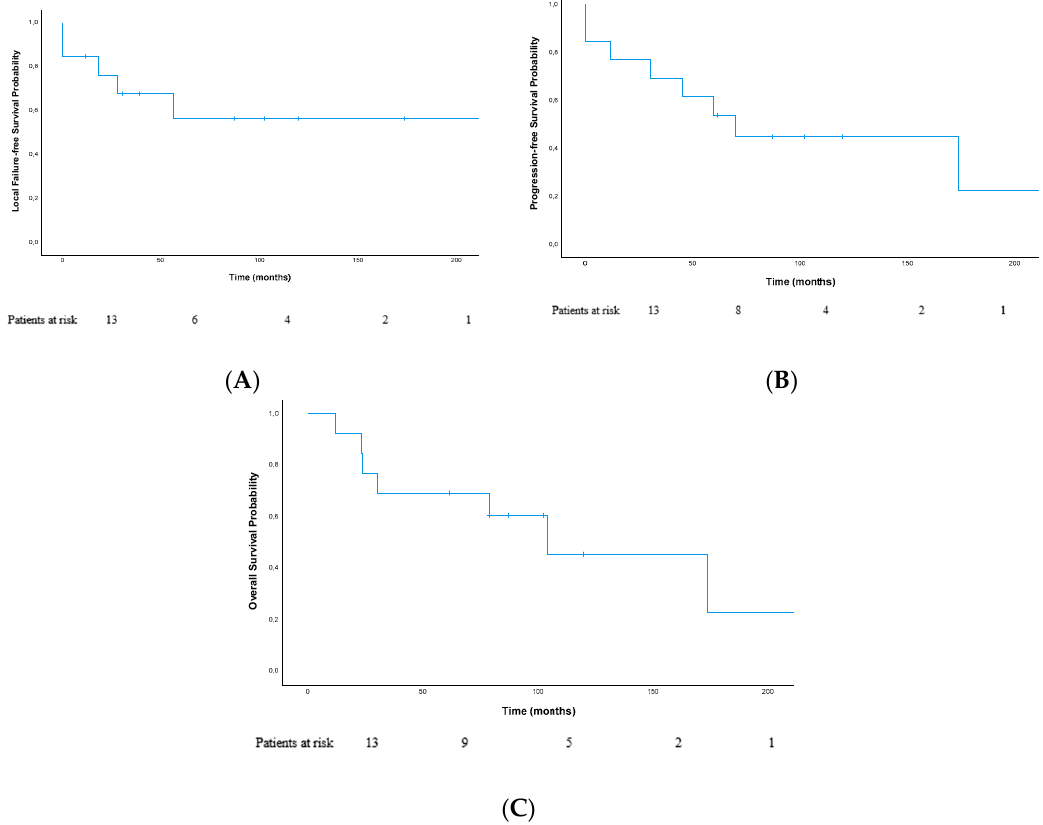
Figure 1. Survival analysis. Kaplan–Meier-estimated ( A ) local failure-free survival (LFFS), ( B ) pro- Figure 1. Survival gression-free survival (PFS), and ( C ) overall survival (OS) of the whole cohort.